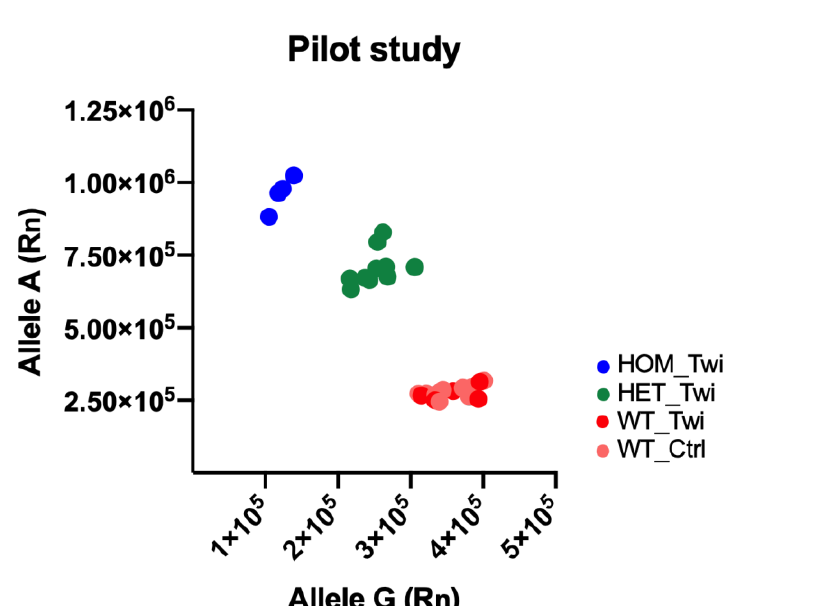
Figure 1. Genotyping of galactosylceramidase ( Galc ) SNP c.355G>A in the Twitcher (Twi) mouse. The Scatter plot of Allele G (axis x) versus Allele A (axis y) allowed us to identify the presence of the SNP in each animal. Animals homozygous for Allele G (WT) were localized in the bottom right corner of the graph (red and pink circles), animals homozygous for Allele A (HOM) were localized in the top left corner of the graph (blue circles), and animals heterozygous for Alleles A and G (HET) were localized on the diagonal (green circles).